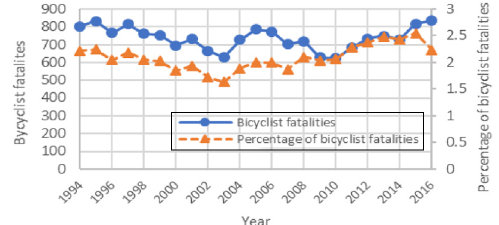
Figure 1 Trends of bicyclist fatalities and fatality rates according to